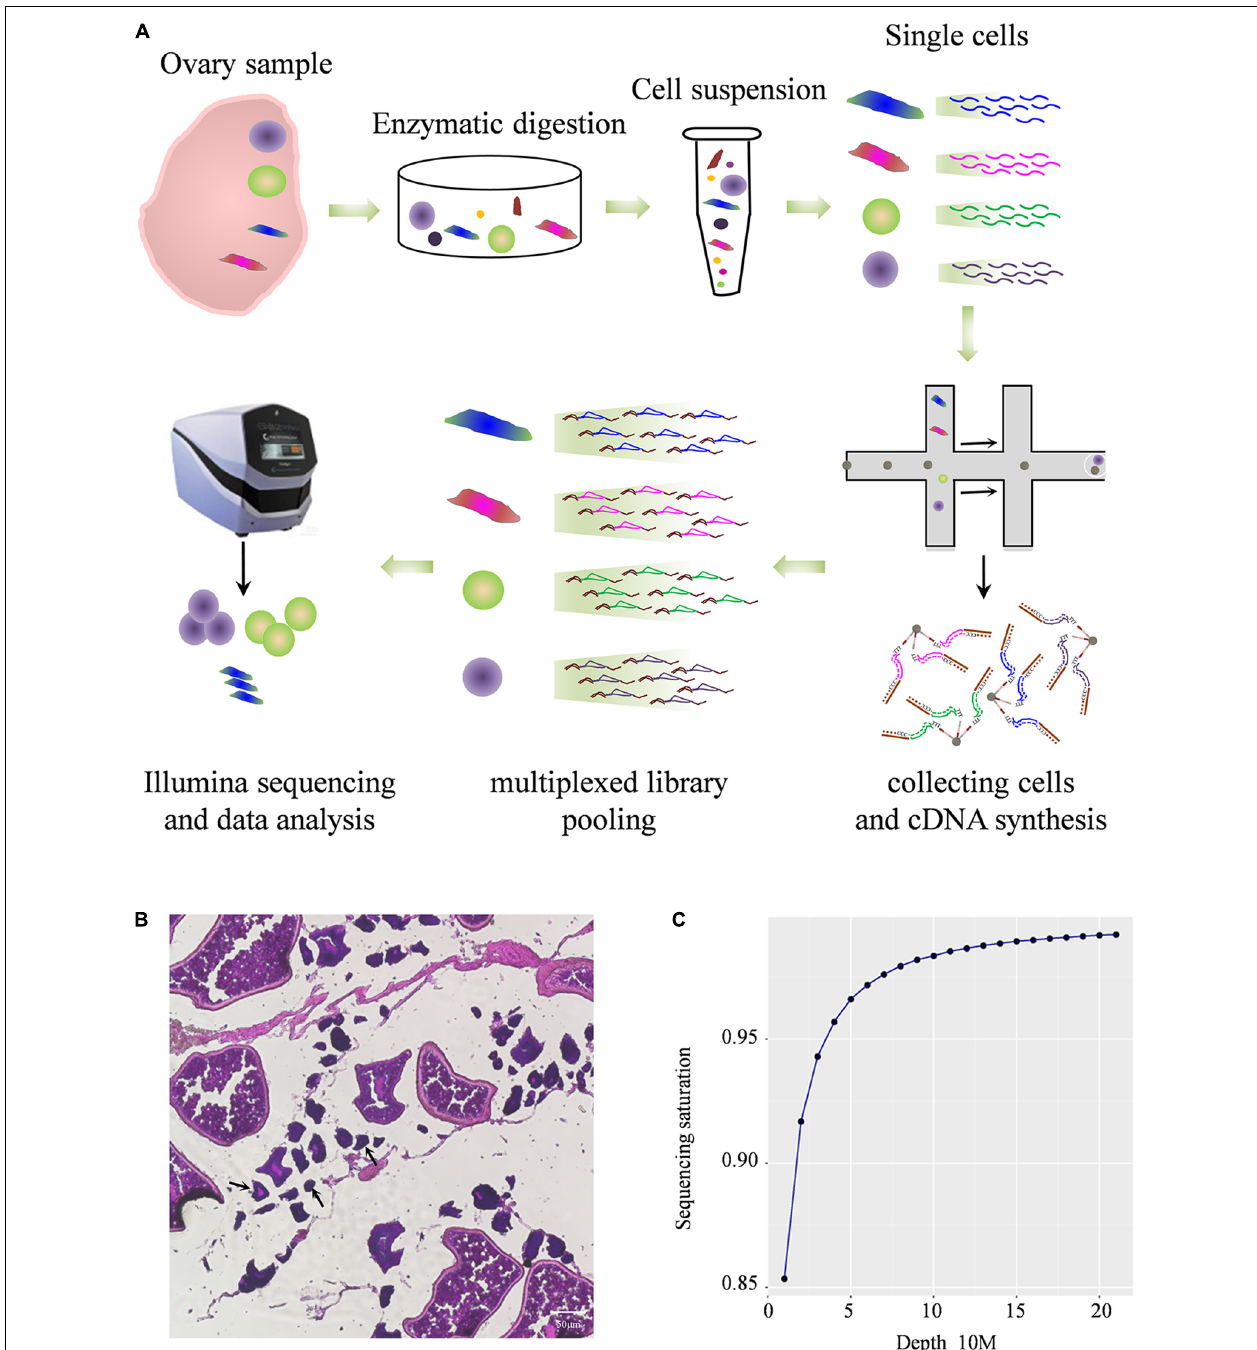
FIGURE 1 | Profiling global expression patterns of Asian sea bass ovary with single-cell RNA sequencing. (A) Schematic illustration of the experimental workflow in this study. (B) Photomicrographs of different type of cells in adult ovary. The arrows indicate cells less than 50 µ m. (C) Saturation analysis of the RNA-Seq data.